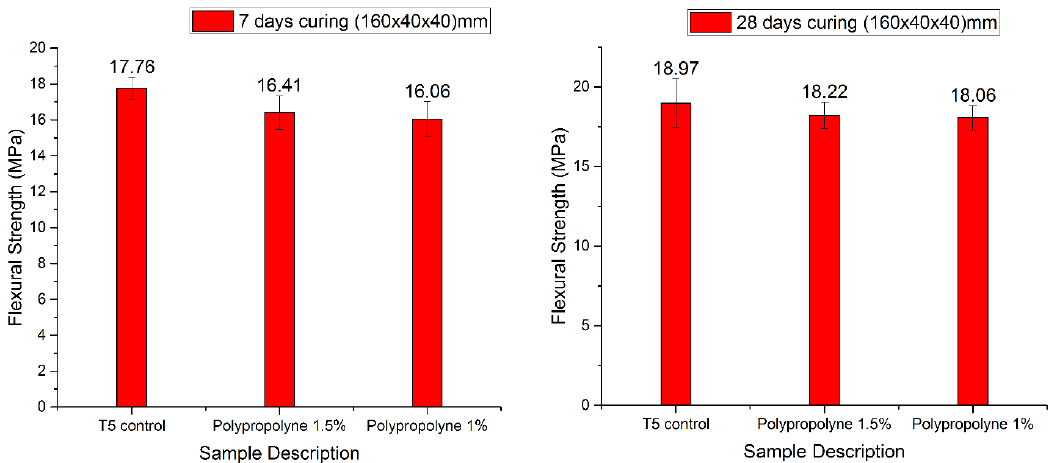
Figure 20. Flexural strength of manual mortar mix after 7-day and 28-day curing (the values specify the actual strengths).